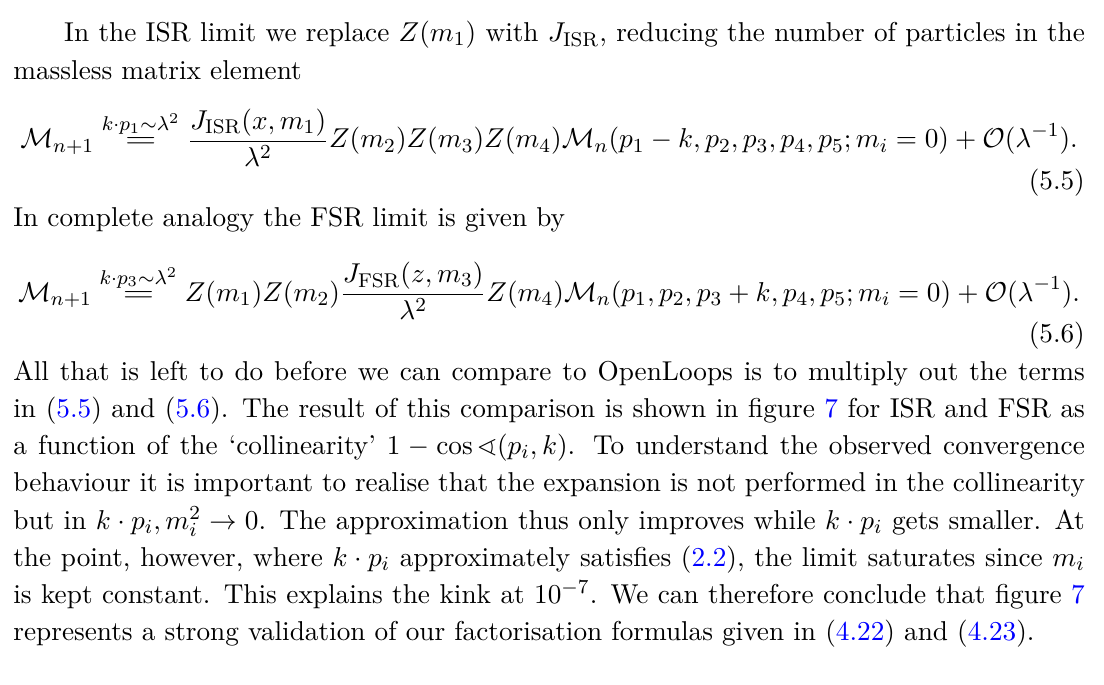
coll at leading power for ISR (5.5) and FSR (5.6) as M OL is calculated with OpenLoops in quadruple M